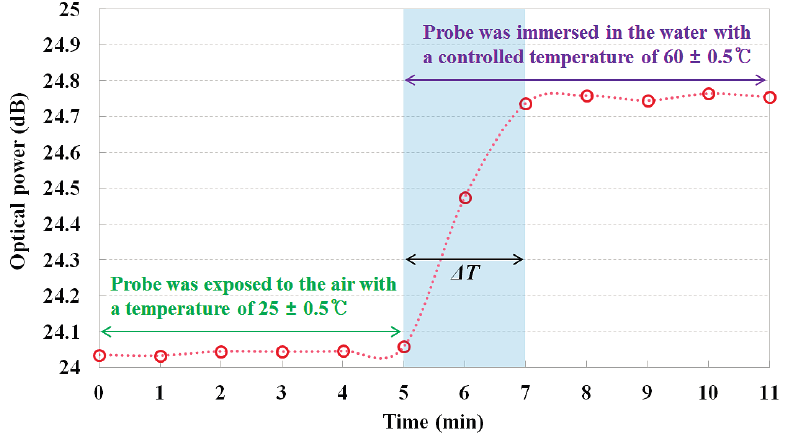
Figure 6. Real-time monitoring of the fiber-optic temperature sensor to measure response